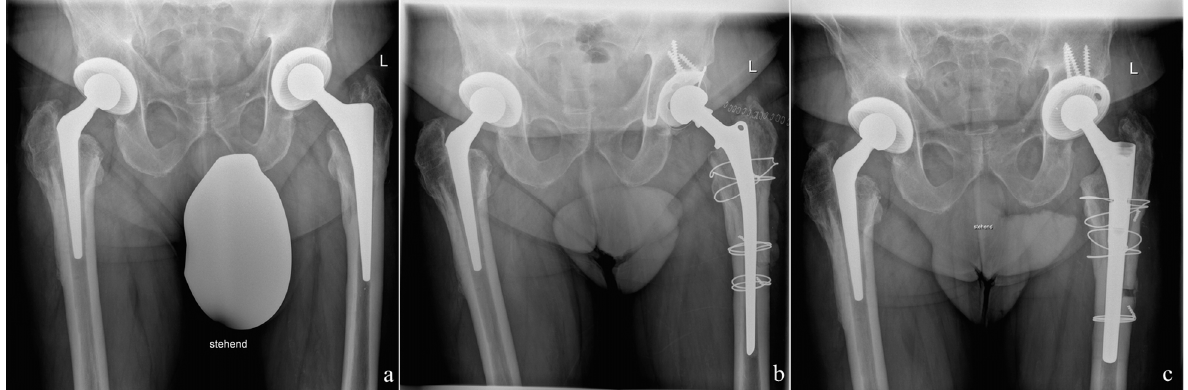
Figure 2. Case with a transfemoral explantation because of a fully osteointegrated prosthetic stem, which was not possible to explant endofemorally. ( a ): Preoperative situation with infected CLS-stem (ZimmerBiomet, Winterthur, Switzerland). ( b ): After transfemoral explantation of the infected prosthesis the interim prosthesis was implanted consisting of a Weber- Stem and acetabular a Ganz-ring with a Müller flat-profile cup (ZimmerBiomet, Winterthur, Switzerland). The Ganz-ring was fixed with only three screws. The transfemoral flap was refixed with 1.5 mm diameter cerclages. ( c ): Situation after reimplantation of the definitive prosthesis consisting of an Allofit S-cup and a Revitan stem (ZimmerBiomet, Winterthur, Switzerland).